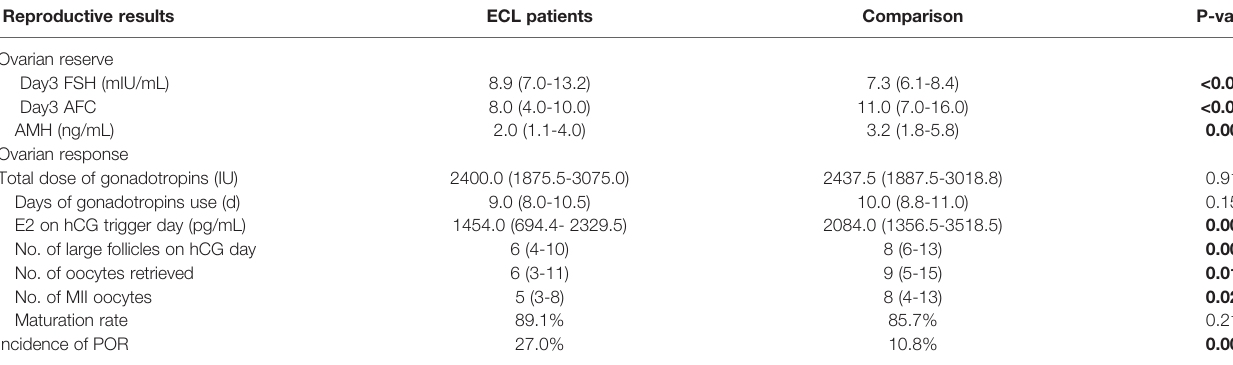
TABLE 2 | Ovarian reserve and response to stimulation in the ECL and comparison groups. Reproductive